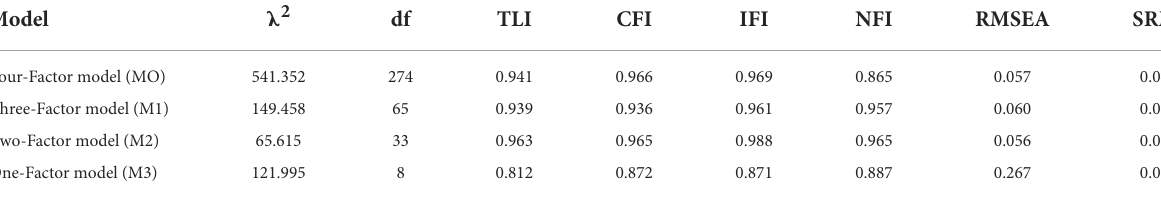
TABLE 2 Results of model comparisons using a CFA approach.